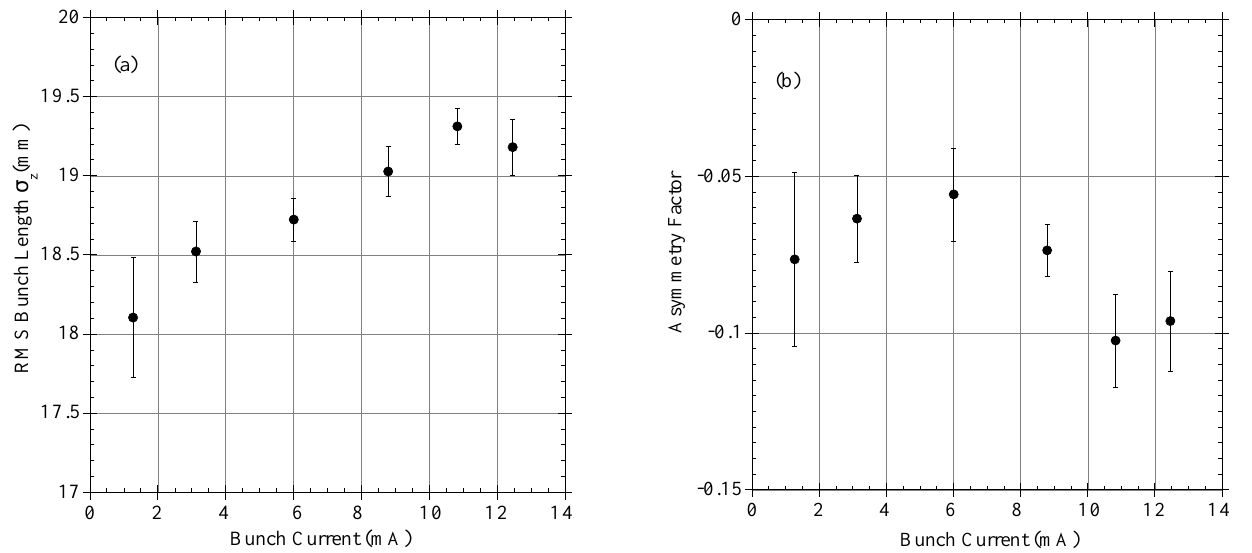
FIG. 5. (a) The electron bunch length as a function of current with 18 bunches in the CESR ring. (b) The asymmetry factor as a function of